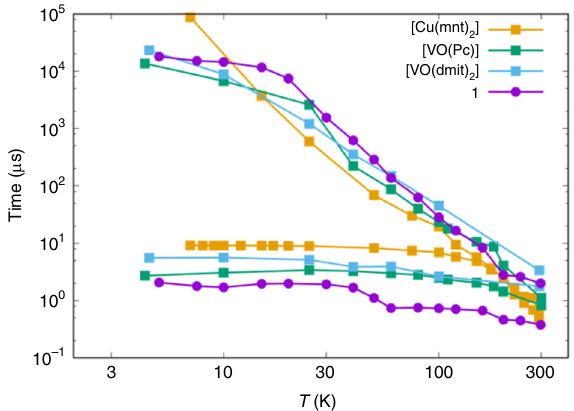
Fig. 5 Spin-lattice and phase memory times for molecular spin qubits. Comparison of T 1 (upper) and T m (lower) as a function of temperature for [Cu(mnt) 2 ] (0.001% solid-state dilution), [VO(Pc)] (0.001% solid-state dilution), [VO(dmit) 2 ] (5% solid-state dilution), and ~2% 1 @